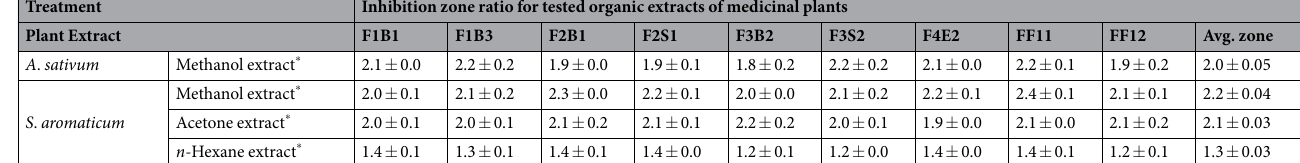
Table 4. In vitro inhibitory activities of disk containing different organic extracts of Syzygium aromaticum and Allium sativum against fish pathogenic E . faecalis isolates. 8 mm filter paper disk soaked with methanol extract of A . sativum , methanol extract of S . aromaticum , acetone extract of S . aromaticum and n -hexane extract of S